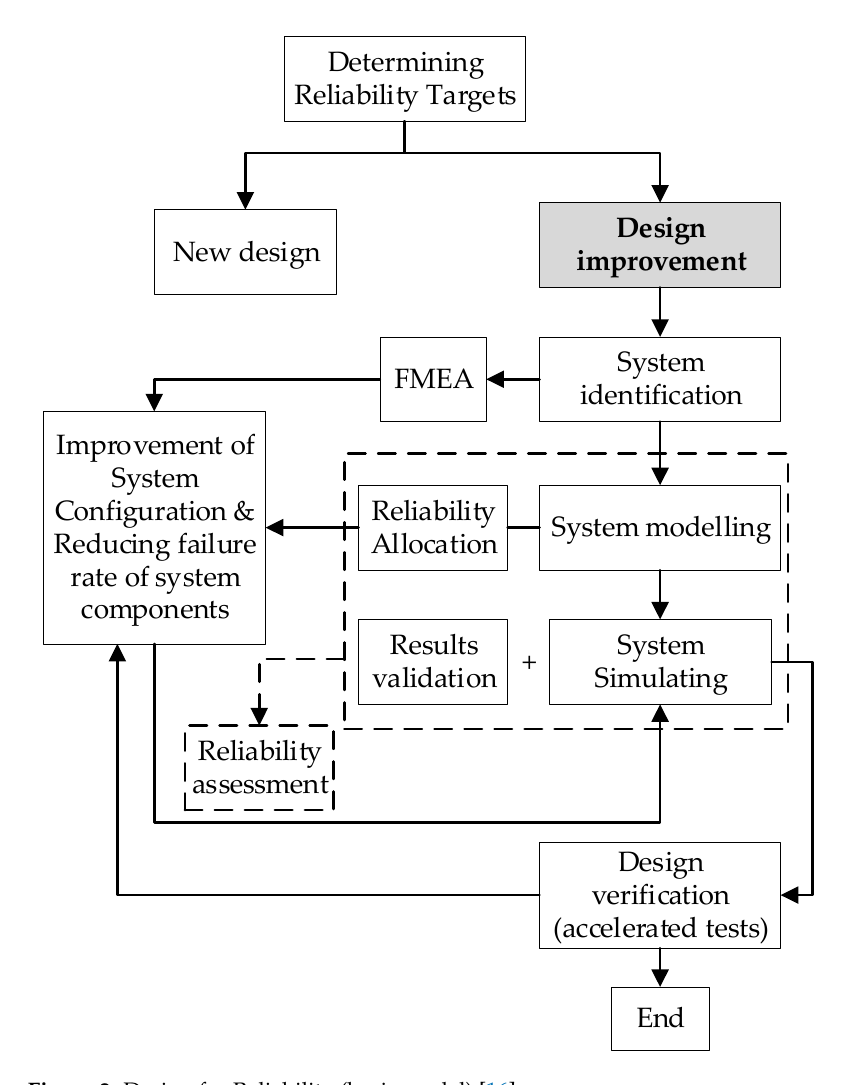
Figure 2. Design for Reliability (basic model) [16].